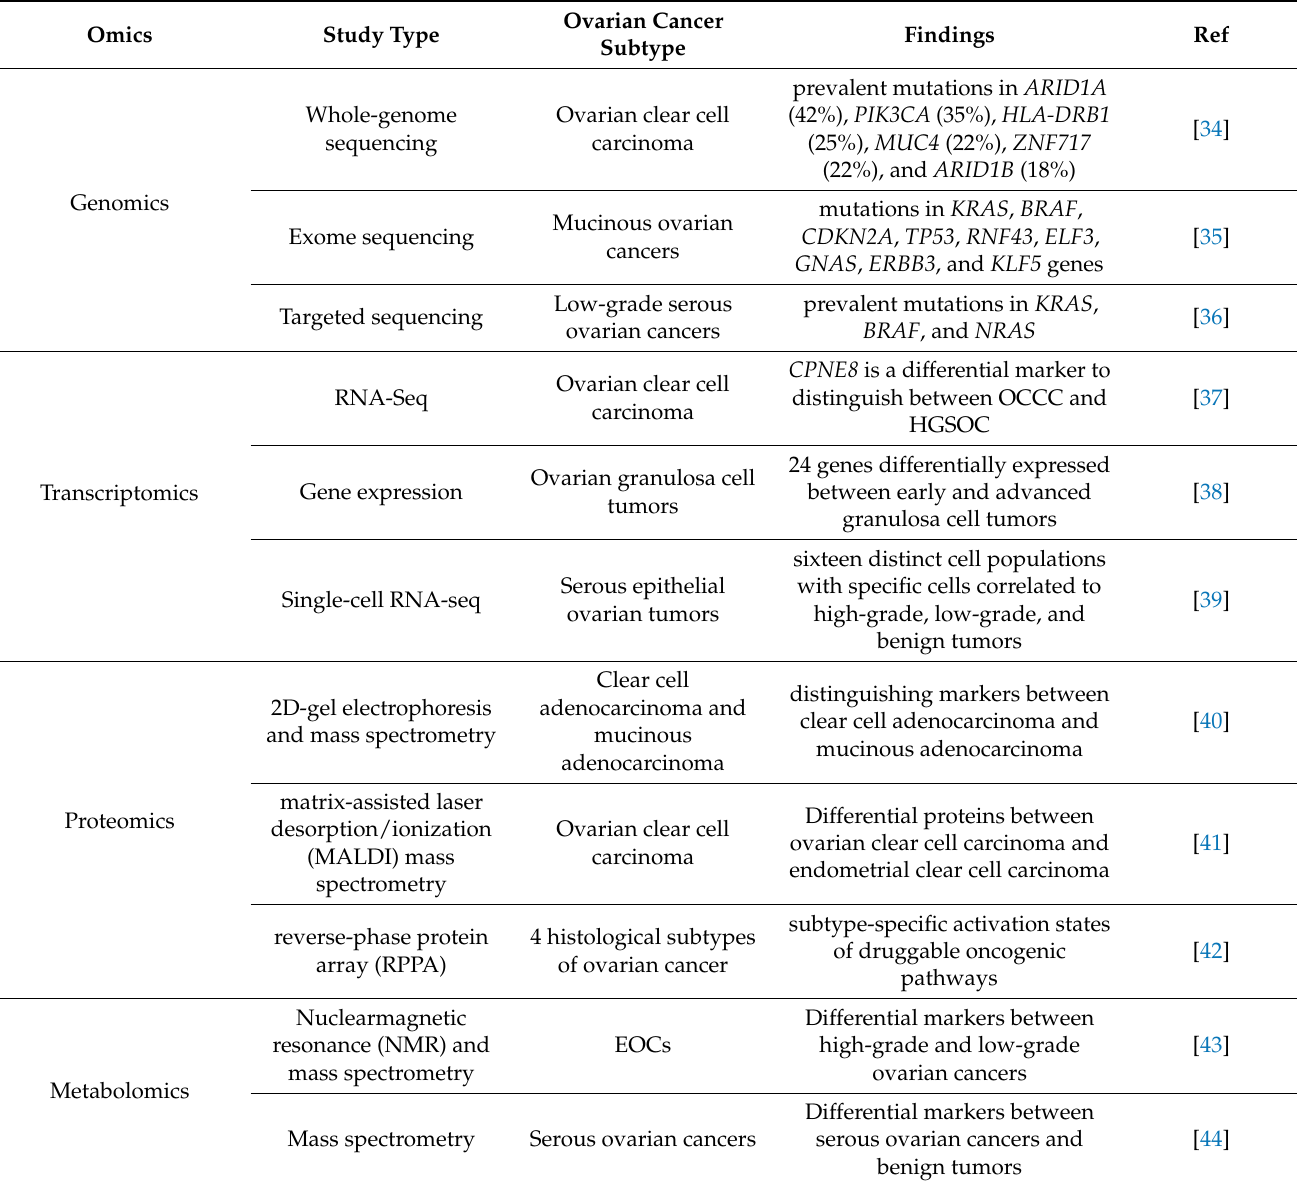
Table 1. A partial list of published omics studies on rare ovarian